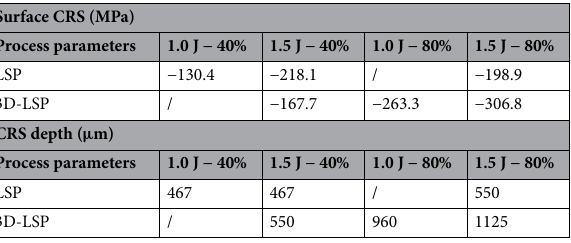
Table 2. Surface CRS (MPa) measured at 55 µ m and CRS depth ( µ m) for specific process parameters of the LSP and 3D-LSP